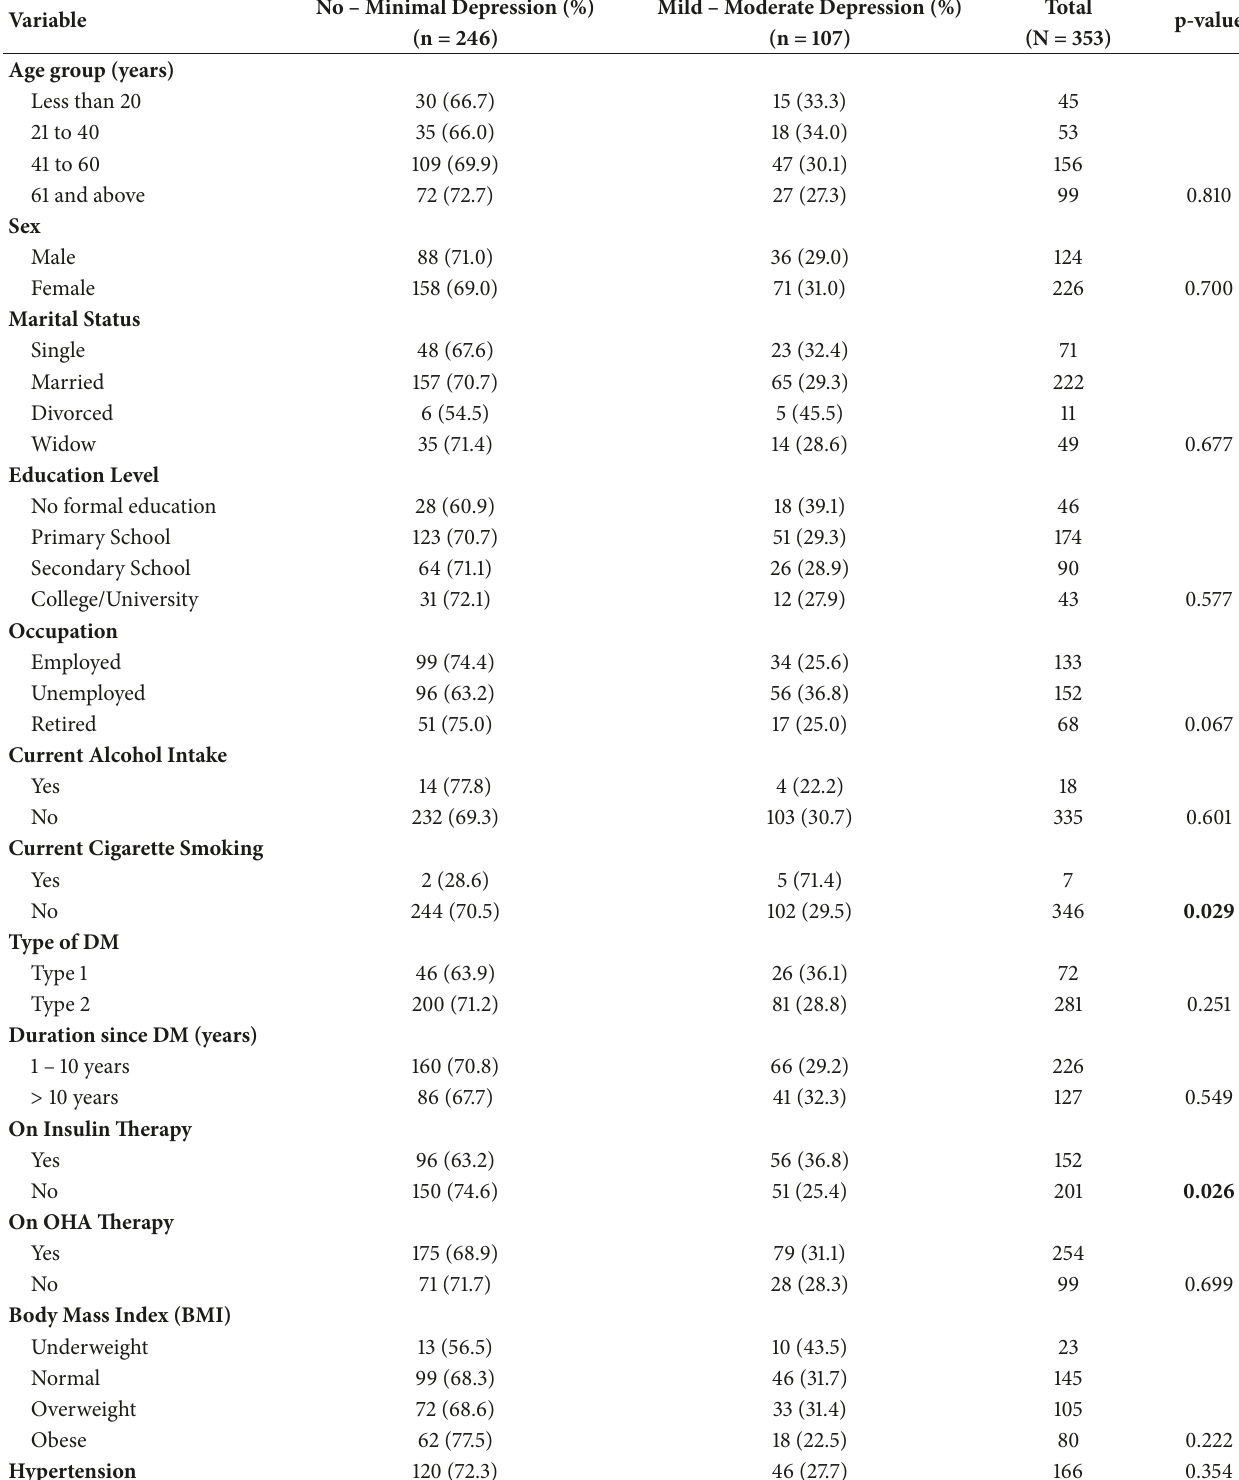
Table 2: Association between depression and clinical/sociodemographic